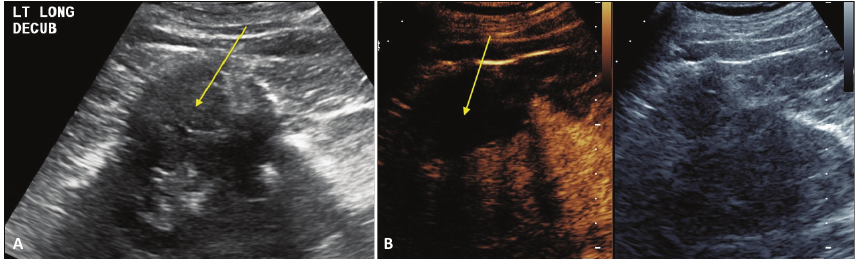
Figure 3. Successful ablation. Patient presented for 3-month post-RFA evaluation. (A) B-mode image before the ablation. Large heterogeneous tumor is noted on gray scale examination (arrow). (B) Absence of residual blood flow (arrow) is demonstrated on CEUS examination.